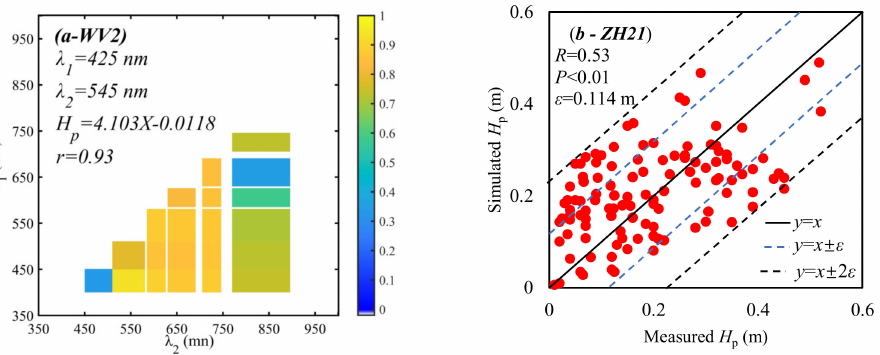
Figure 5. Panel ( a ) is OBRA of WV2 for H p . Panel ( b ) is the validation of pond depth retrieved by the ZH21 algorithm and in situ